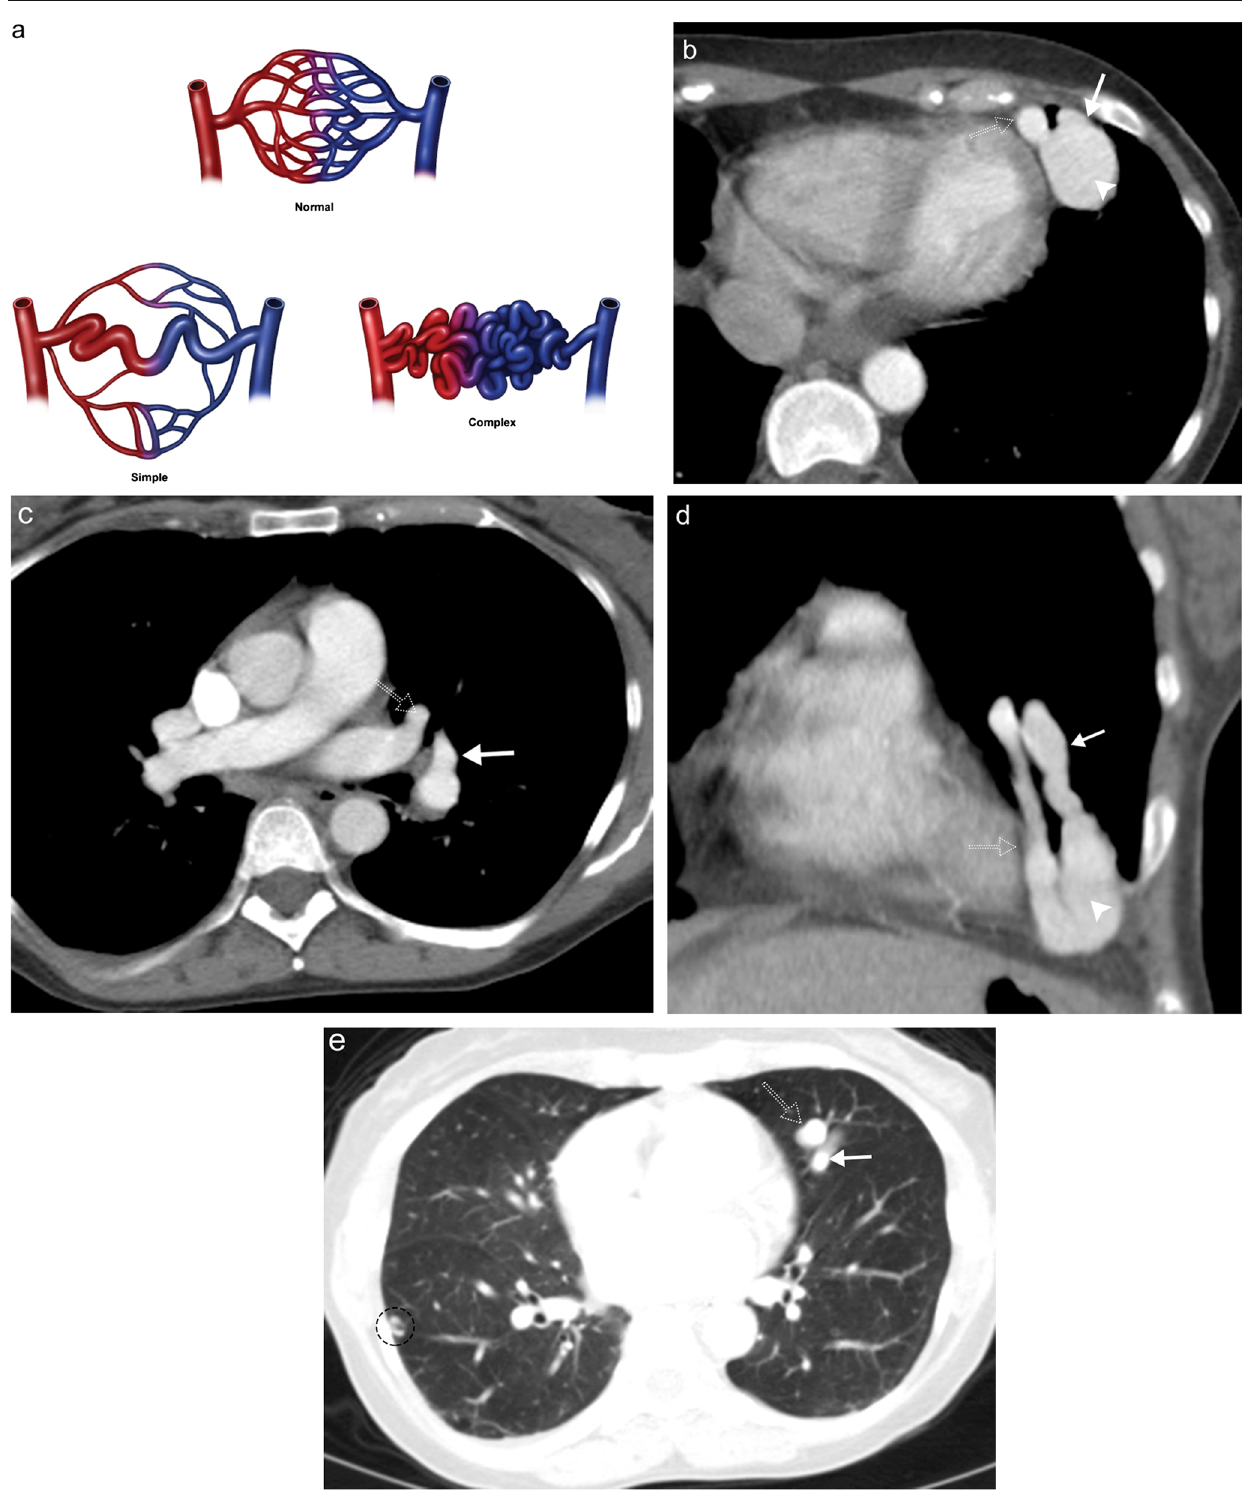
Fig.17 Pulmonary arteriovenousmalformation. a Conceptual illustration of simple versus complex arteriovenous malformation. Axial ( b, c ) and coronal ( d ) contrast-enhanced CT images demonstrate a large arteriove- nous malformation of the left upper lobe ( arrowhead ) with a clearly identifiable feeding pulmonary artery ( solid arrow ) and draining